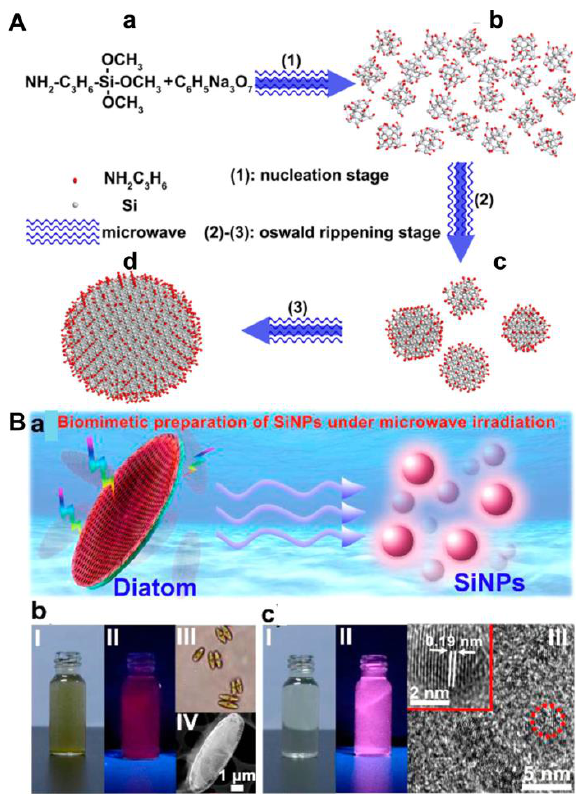
Figure 1. ( A ) Schematic illustration of bottom-up one-pot synthesis of SiQDs. (a) reaction precursor; (b) twenty-one nuclei; (c) four small-size nanocrystals; (d) one large-size nanocrystal. Reproduced from [18], with permission from American Chemical Society, 2013. ( B ) (a) Schematic illustration of biomimetic synthesis of SiQDs. (b) I and II indicate the diatom precursor solution under ambient light (left) and 365 nm irradiation (right), respectively; III and IV present a microscope photo and TEM image of the diatoms, respectively. (c) I and II indicate the as-prepared SiQD sample solution under ambient light (left) and 365 nm irradiation (right), respectively; III shows an high resolution TEM (HRTEM) image of the SiQDs with high crystallinity. The inset in (III) presents the enlarged HRTEM image of a single SiQD. Reproduced from [37], with permission from American Chemical Society, 2015.